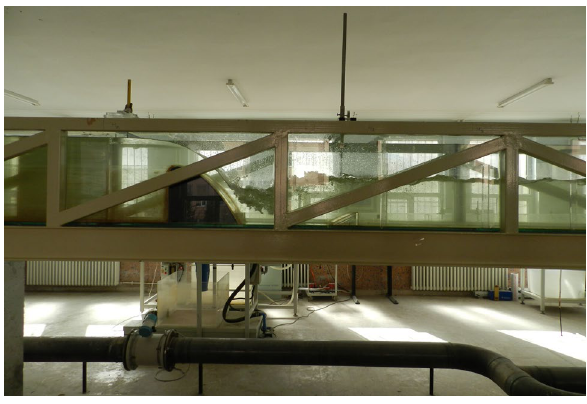
Fig. 6 Laboratory view of the experimental setup. a Dimensions and laboratory view. b Single-row placement in plan. c Two-row place- ment in plan. d Two rows without end sill in